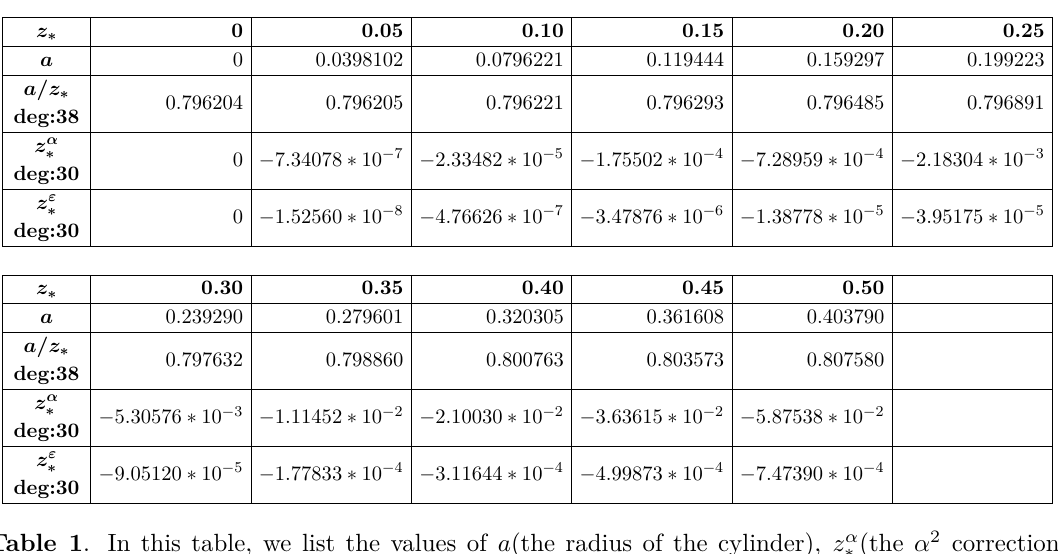
Table 1 . In this table, we list the values of a (the radius of the cylinder), z α to the maximum value of z ), and z ε (the ε 2 α 2 correction to the maximum value of z ∗ ∗ values of z . These values are obtained by solving boundary condition (4.7). Solutions are obtained ∗ upto O ( a 38 ) for z solution and upto O ( a 30 ) for z ( α ) and z ( ε ) 0